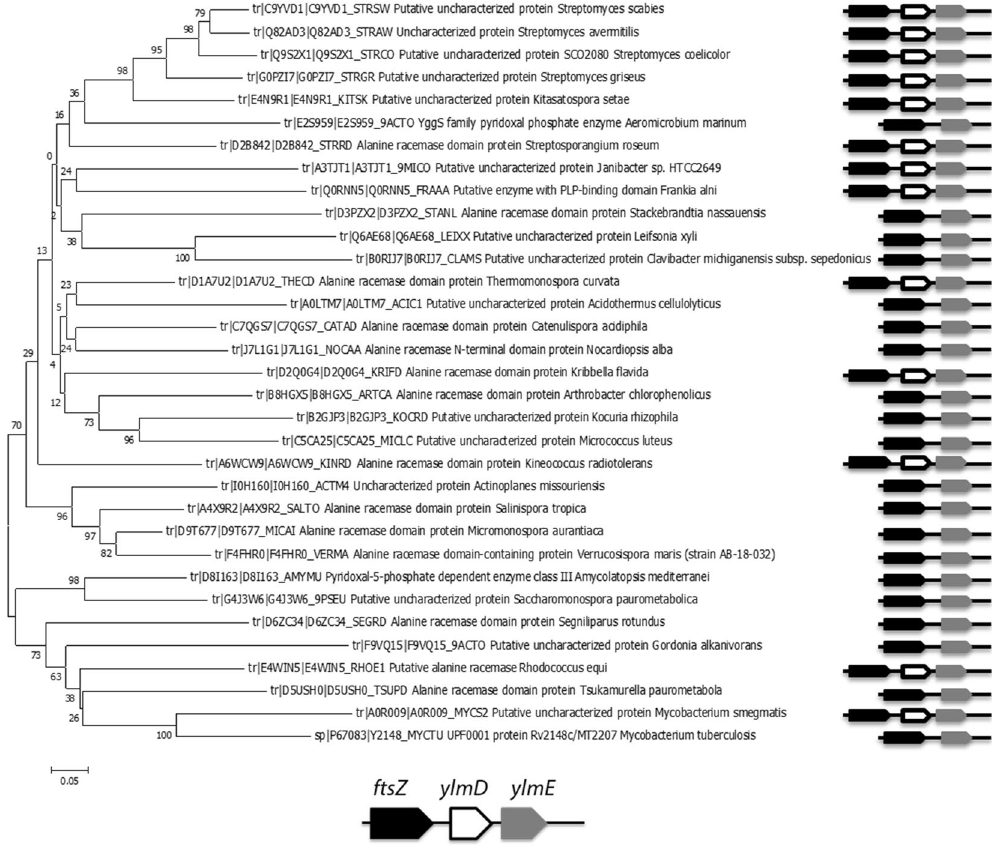
Figure 1. Phylogenetic analysis of YlmE in actinobacteria and its genetic linkage to YlmD. A phylogenetic tree is shown of YlmE in actinobacteria (left) and genetic linkage of ylmE (grey) to ftsZ (black) and ylmD (white)